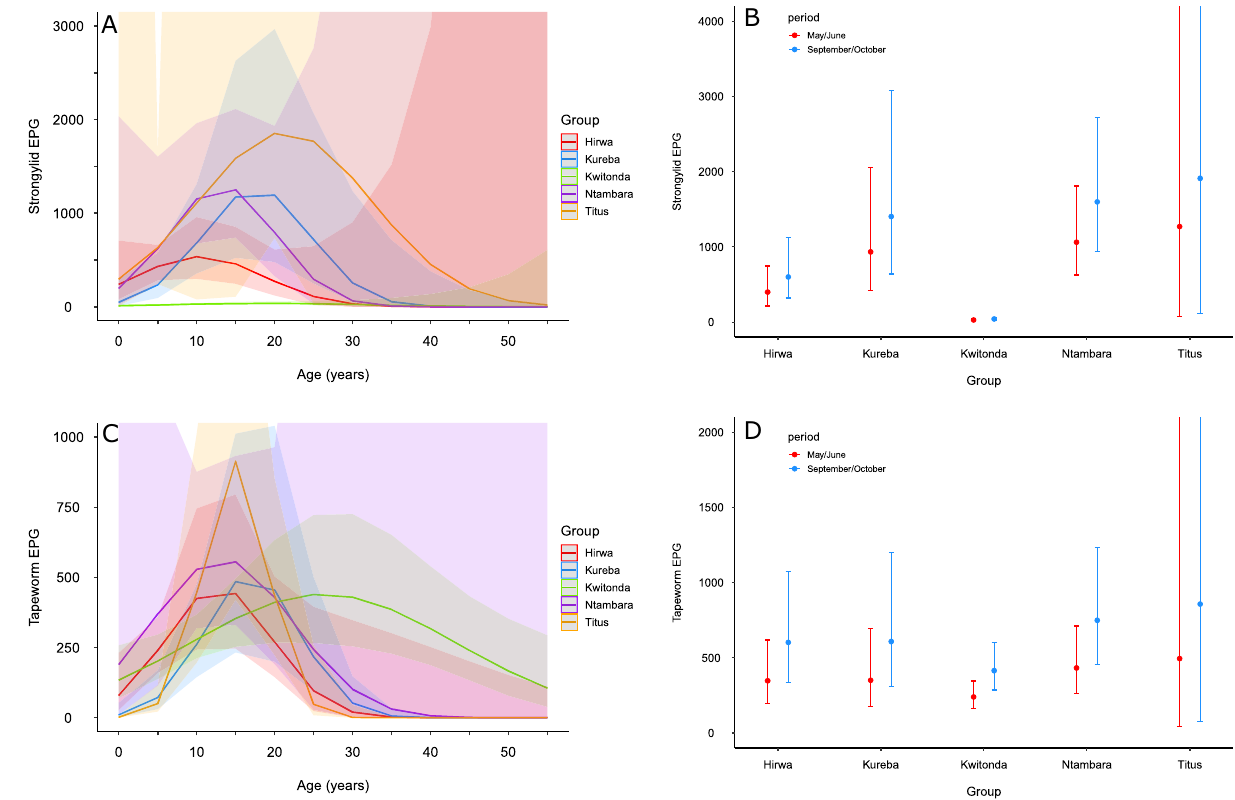
Figure 5. Models’ predicted mean values with 95% confidence intervals for the factors affecting helminth infections in individually sampled mountain gorillas in Virunga Massif (dataset 3). ( A ) strongylid eggs per gram (EPG)—group identity and age effects, ( B ) strongylid EPG—sampling period (season) and group identity effects, ( C ) tapeworm EPG—group identity and age effects, ( D ) tapeworm EPG—sampling period (season) and group identity